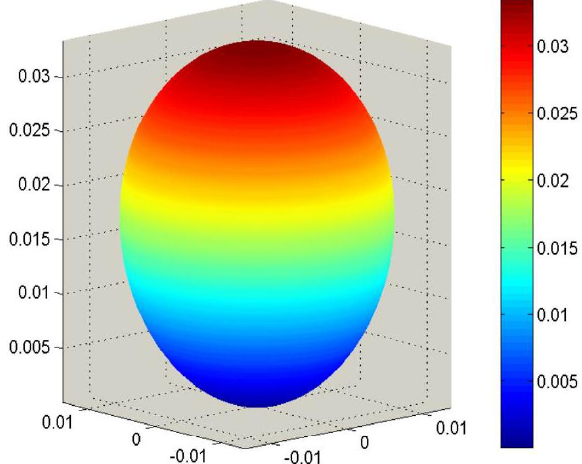
Figure 7. Longitudinal surface representation, g ( h ) (Vm/N), for the voltage piezoelectric constant of a PMN-PT single